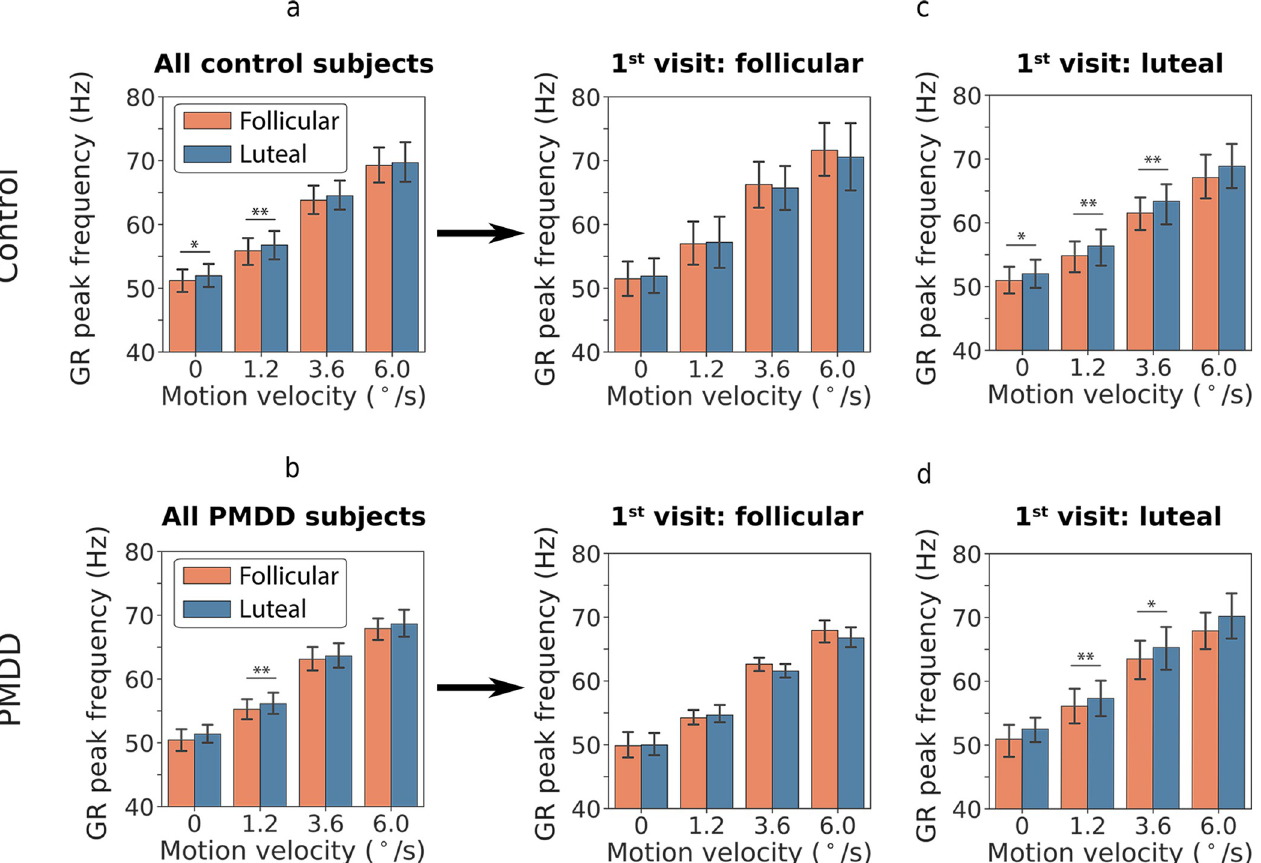
Fig 4. Effect of the phase of the menstrual cycle on the weighted peak frequency of gamma response (GR). The data are shown for four motion velocity conditions (‘static’: 0˚/s, ‘slow’: 1.2˚/s, ‘medium’: 3.6˚/s, ‘fast’: 6.0˚/s). (a) and (b) show comparison of the GR weighted peak frequency in the luteal and follicular phases separately for all control (a) and all PMDD (b) subjects. (c, d) show comparison of the GR weighted peak frequency in the luteal and follicular phases separately for those subjects, who came for the first investigation during their follicular (c, d left panel) or luteal (c, d right panel) phase. Error bars represent 95% confidence intervals. � p < 0.05; �� p <